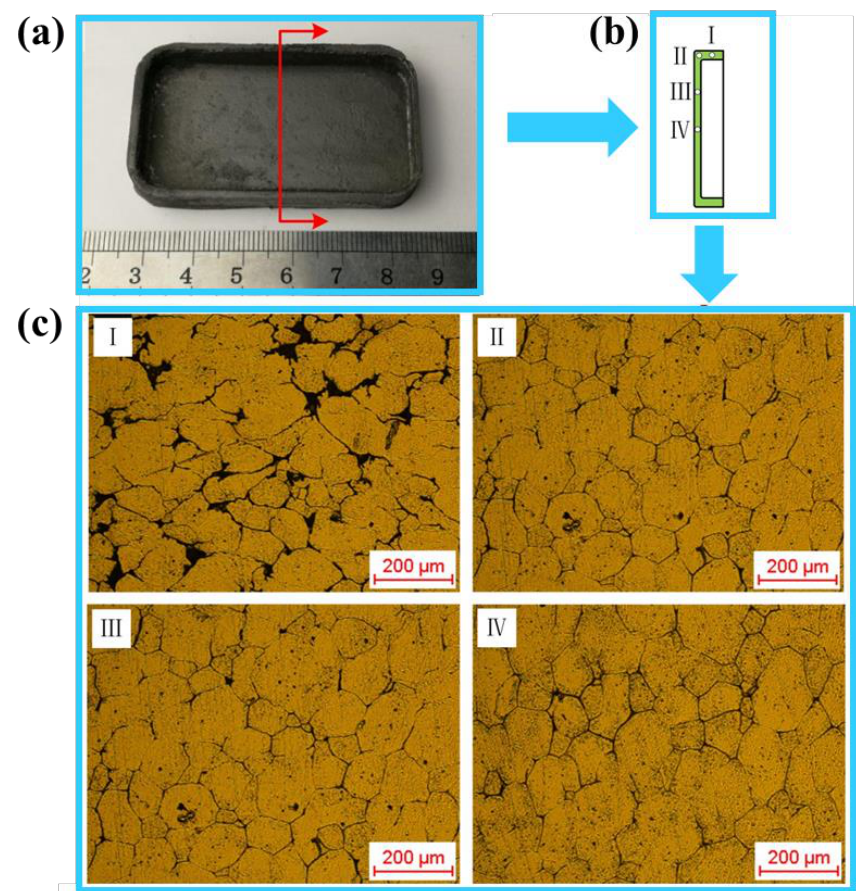
Figure 15. The macromorphology and microstructure at different sampling positions of the mobile phone shell process by semi-solid thixotropic extrusion forming: ( a ) macro morphology, ( b ) sampling positions, and ( c ) microstructure.